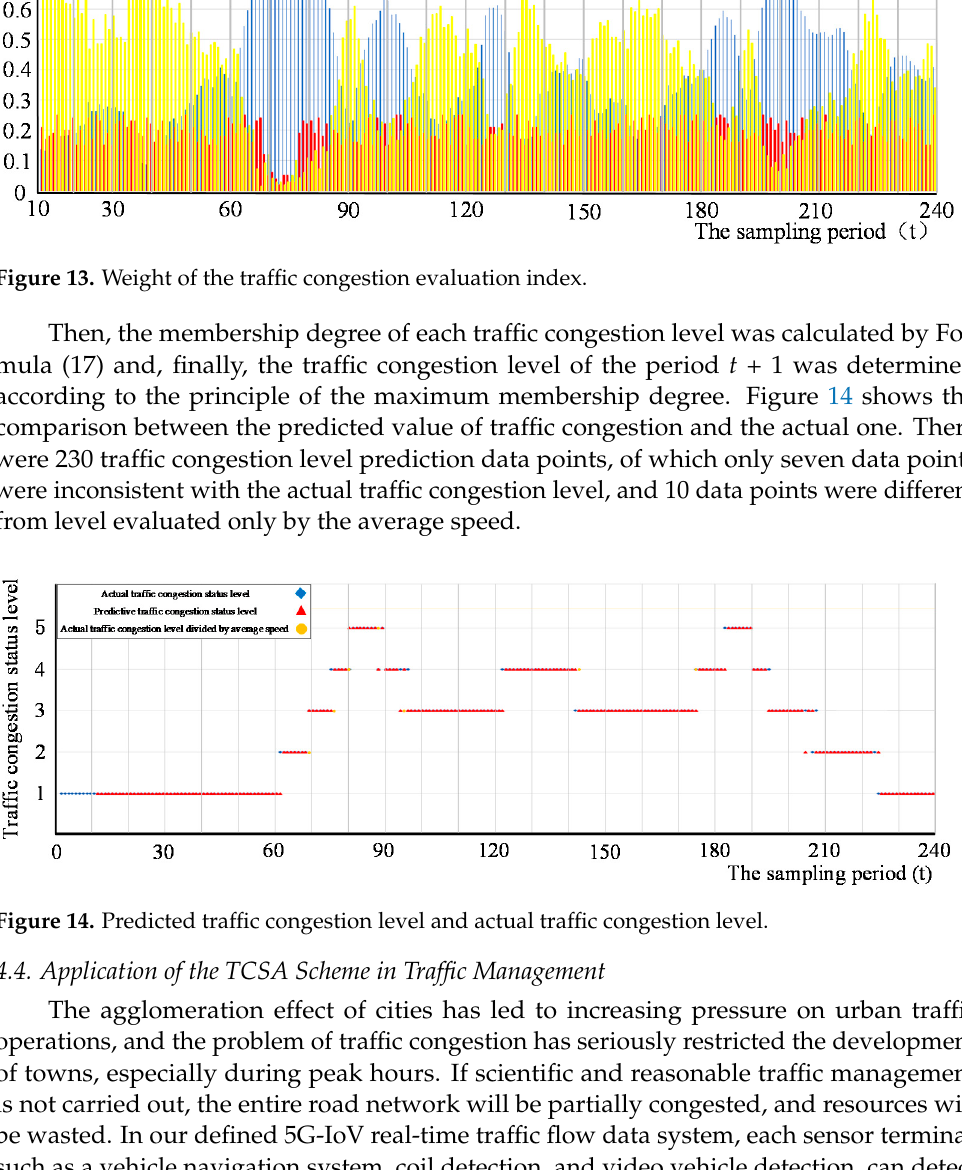
Figure 14. Predicted traffic congestion level and actual traffic congestion level.